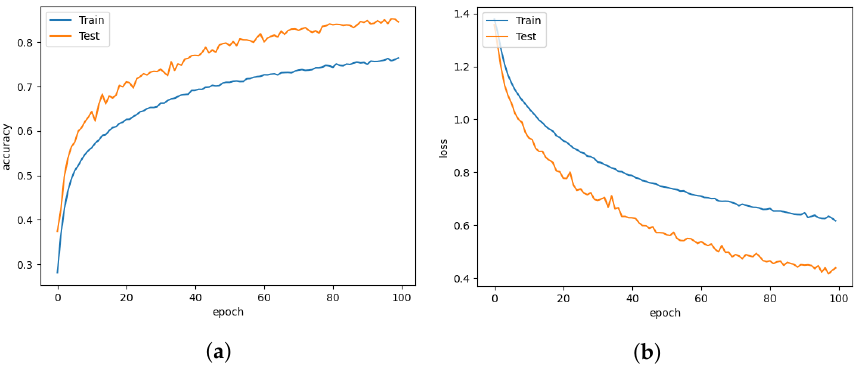
Figure 10. VGGNet for learning rate = 0.001. ( a ) Model accuracy. ( b ) Model loss.